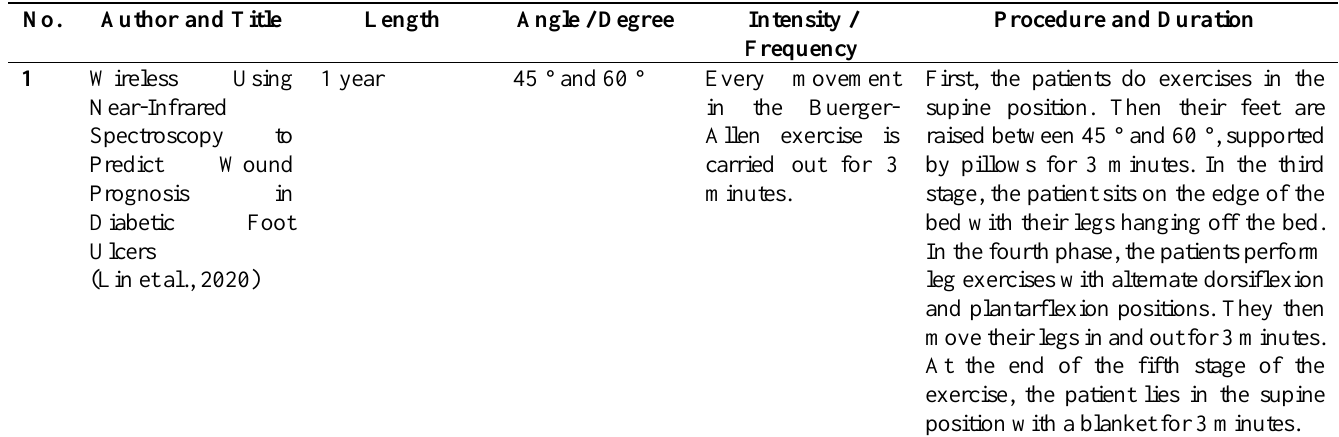
Table 2 Characteristics of the Buerger-Allen Exercise